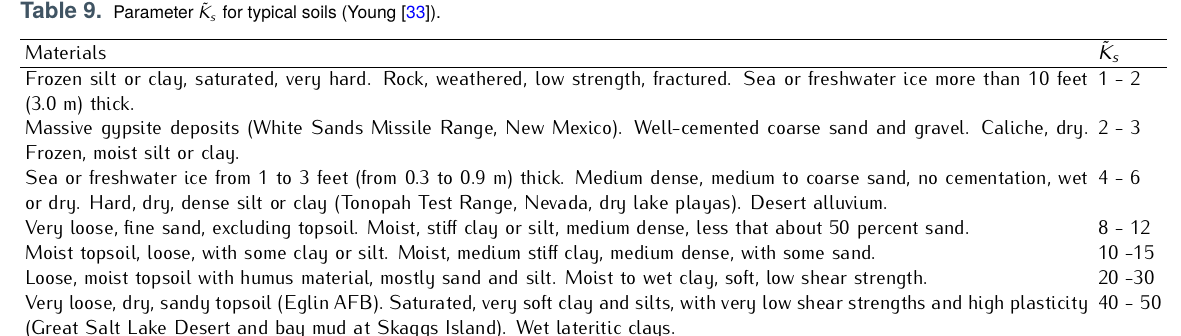
Table 9. Parameter ˜ K